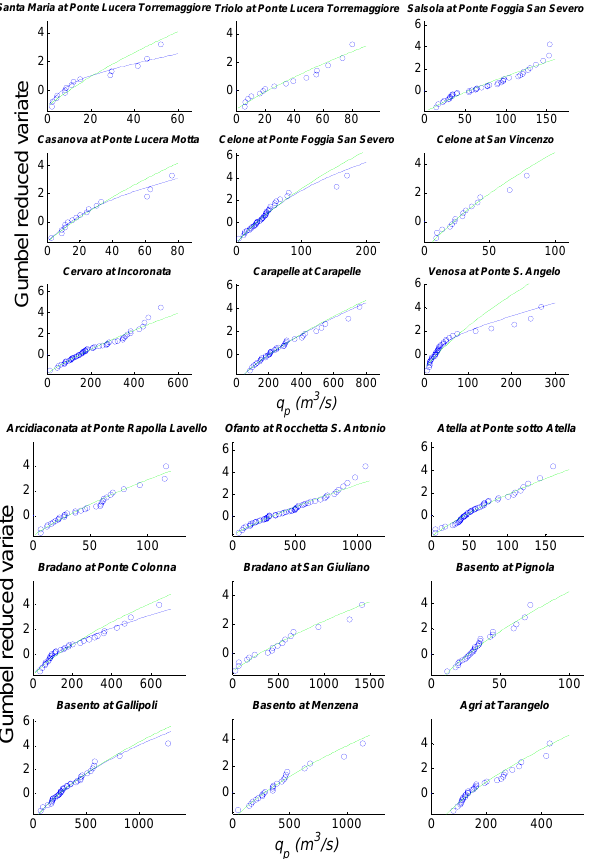
Figure 2b. Probability plots of IF and TCIF distributions vs AMFS - plotting Fig. 2b. Probability plots of IF and TCIF distributions vs. AMFS – positions. plotting positions.